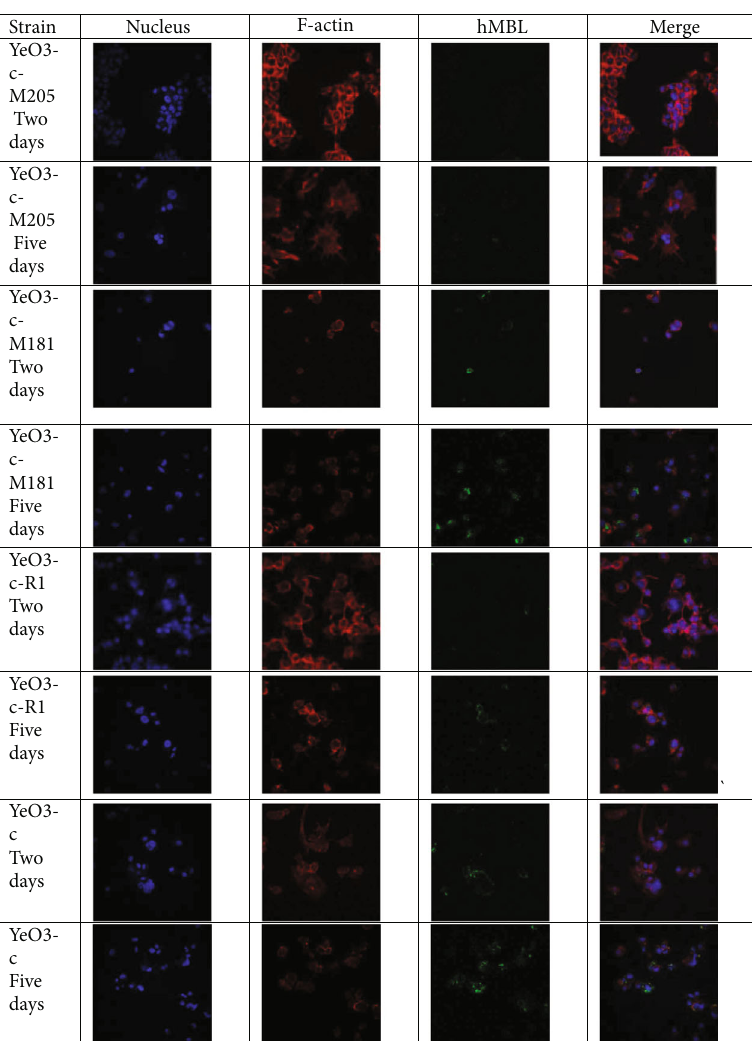
Figure 2: In vitro processing of Yersinia LPS. PMA di ff erentiated THP-1 cells were fed with heat-killed bacteria of various chemotypes. After 2 or 5 days of cultivation, cells were fi xed with PFA and incubated with human serum as a source of MBL. The cell-surface bound MBL was detected with an MBL-speci fi c monoclonal antibody and Alexa Fluor 488 labelled secondary Group IV . Synovial fl uids positive for antibodies recog- nizing Kdo-lipid A region and OPS and OC and partially positive for the IC but negative for antibodies recognizing IC not substituted with ECA in YeO3-c-OCR-ECA LPS. Group V . Synovial fl uids positive for antibodies recog- nizing Kdo-lipid A region as well as OC and partially recog- nizing IC substituted or not substituted with ECA.